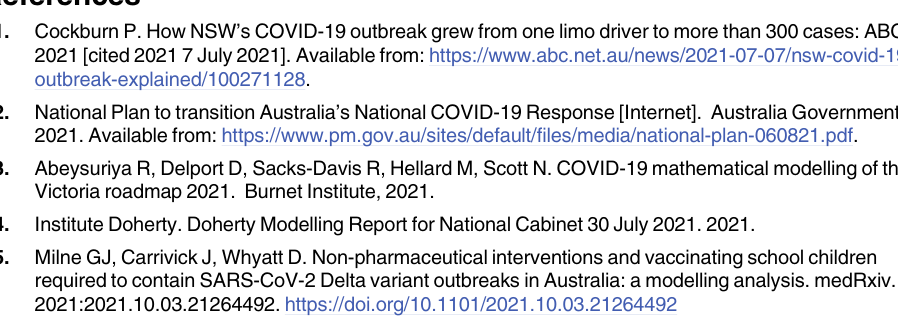
S5 Text. Sensitivity analysis. Table A NSW: Per capita (AUD and %) differences from Open- ing Up at alternative vaccination rate to the preferred vaccination rate (80%). Table B NSW: Sensitivity of preferred vaccination rate to the effectiveness of public health measures after opening up at reducing community transmission and the speed of vaccination. Table C NSW: Sensitivity of preferred vaccination rate to economy lockdown cost and community transmis- sion during lockdown. Table D VIC: Per capita (AUD and %) cost differences of alternative vaccination rates to the preferred vaccination rate (90%). Table E VIC: Sensitivity of the pre- ferred vaccination rate to the effectiveness of public health measures after opening up and speed of vaccination. Table F VIC: Sensitivity of preferred vaccination rate to economy lock- down costs and rate of community transmission during lockdown Table G WA: Per capita (AUD and %) cost differences of alternative vaccination rates to the preferred vaccination rate (89%). Table H WA: Sensitivity of preferred vaccination rate to the effectiveness of public health measures after opening up at reducing community transmission and speed of vaccina- tion. Table I WA: Sensitivity of preferred vaccination rate to opening up with the probability of seeding and state border closure